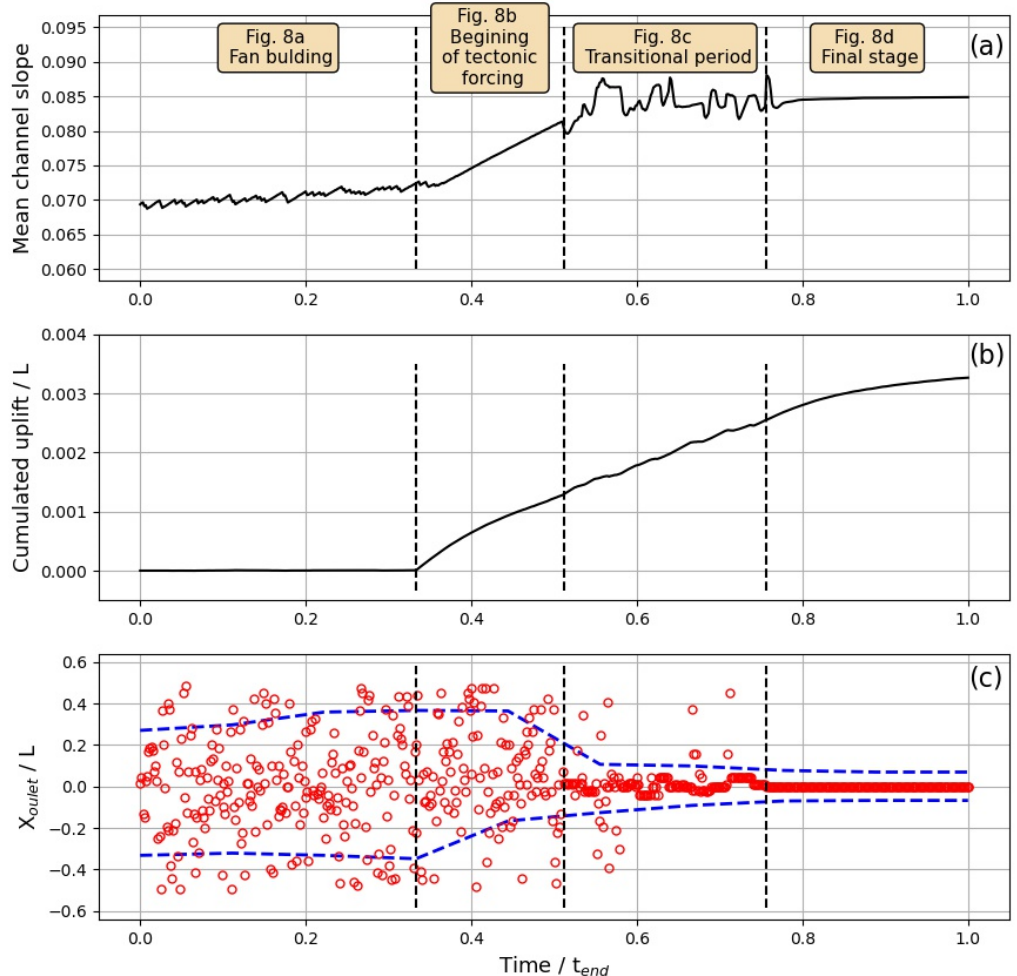
Figure 9. Time evolution of morphological metrics over a time period of t end , which includes the last stage of the fan building period over t end /3 and tectonic forcing over the last 2 t end /3. Round wheat boxes give the number of figures associated with the four stages described Figure 8. ( a ) Time variation of the channel slope along the main central valley. ( b ) Mean accumulated vertical displacements along the fault scarp, which includes both tectonic uplift and fan deposition. ( c ) Red circles give the location of channel outlets along the fault scarp obtained from numerical modeling. Dashed blue lines are the envelope defined by the local maxima and minima observed in the experimental approach (see Figure